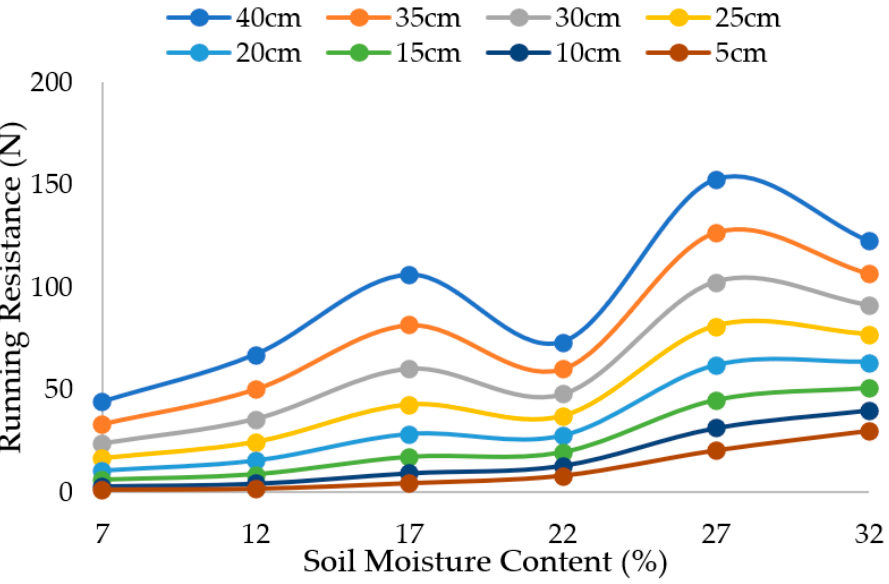
Figure 20. The running resistance at different grouser heights with different moisture contents.